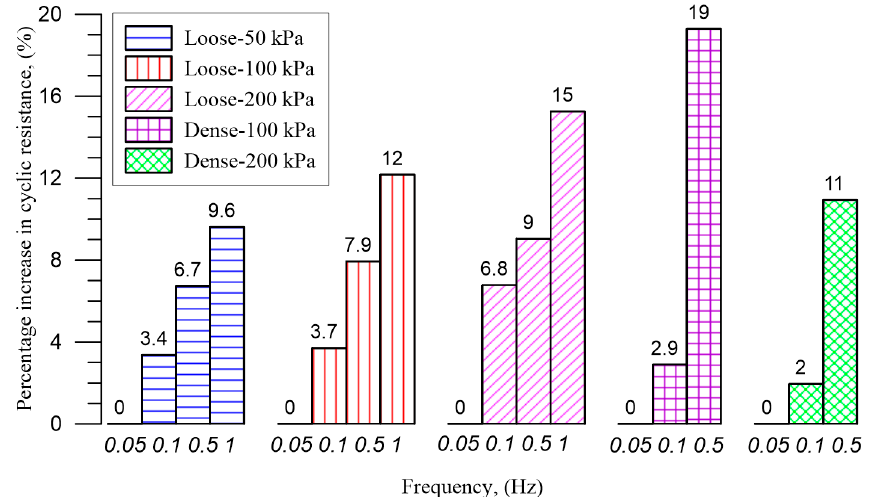
Figure 9. Percentage increase in cyclic resistance at 0.1, 0.5 and 1 Hz relative to the cyclic resistance at 0.05